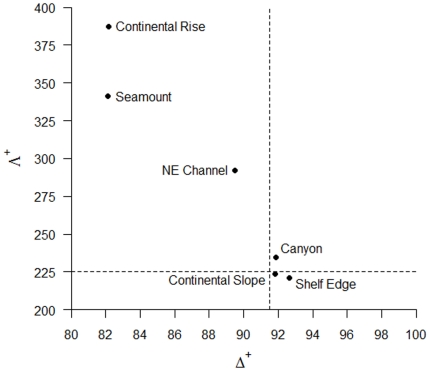
Taxonomic distinctness values by sub-region.Scatter plot of variation in taxonomic distinctness (Λ+) against average taxonomic distinctness (Δ+) values for species lists from 6 sub-regions, showing a strong negative correlation (Pearson's r = −0.87, p<0.05). Dotted lines denote Δ+ and Λ+ values of the master species list from Figs 6 & 7.